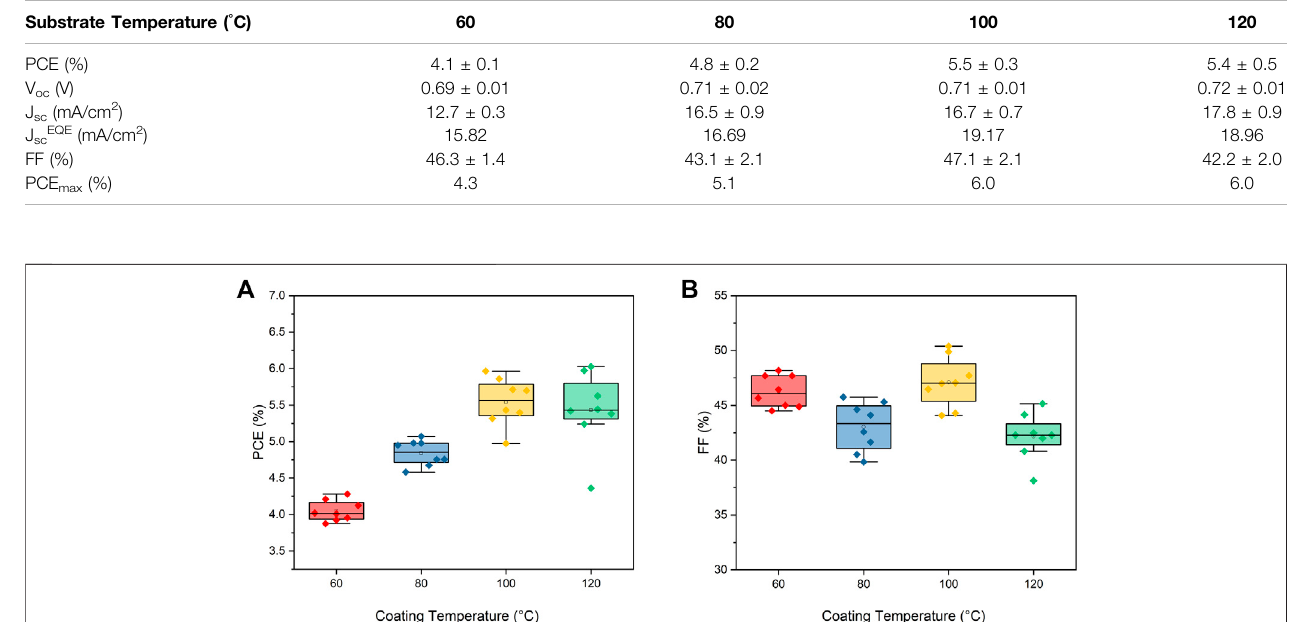
FIGURE3| StatisticrepresentationofthemeasuredPVparametersofPM6:Y6devicesfabricatedatdifferenttemperatures: (A) PowerConversionEf fi ciency(PCE) and (B) Fill Factor (FF).